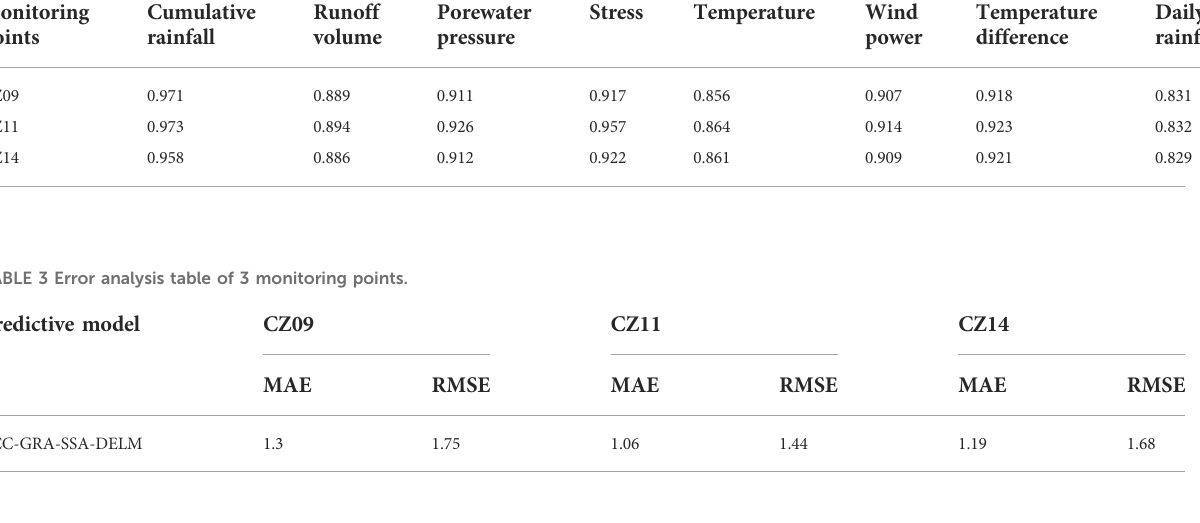
TABLE 2 The correlation between the in fl uence factors of the three monitoring points and the displacement. Monitoring points